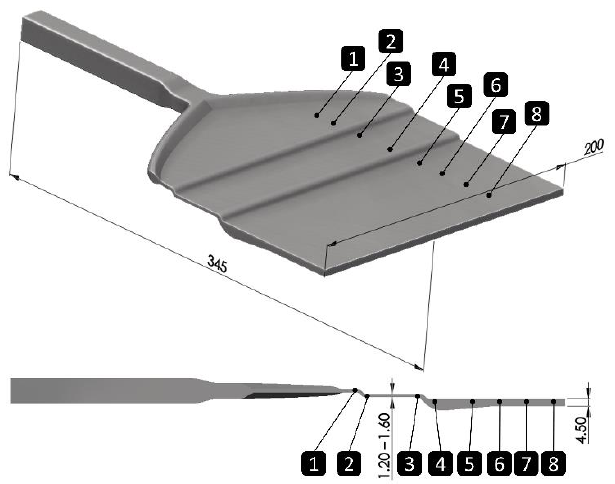
Figure 8. Schematic representation of the melt imprint indicating sample positions 1 to 8 for spectroscopic analysis via confocal Raman microscopy.